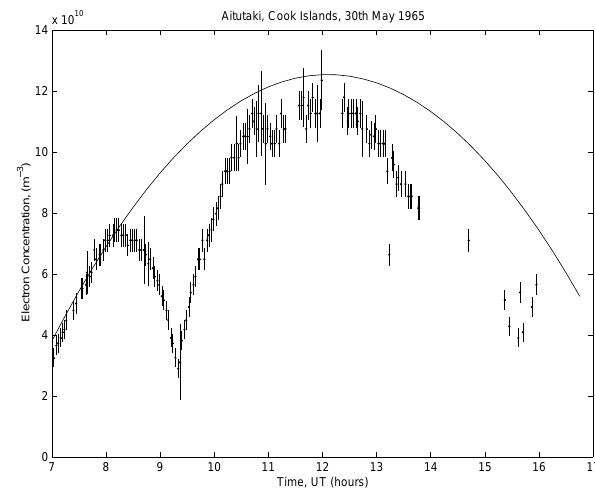
Fig. A3. The variation of the E region peak electron concentration with time during the eclipse of 30 May 1965 at Aitutaki, Cook Is- lands (points). The control day is represented by a polynomial fit to the data from an adjacent day (solid line).